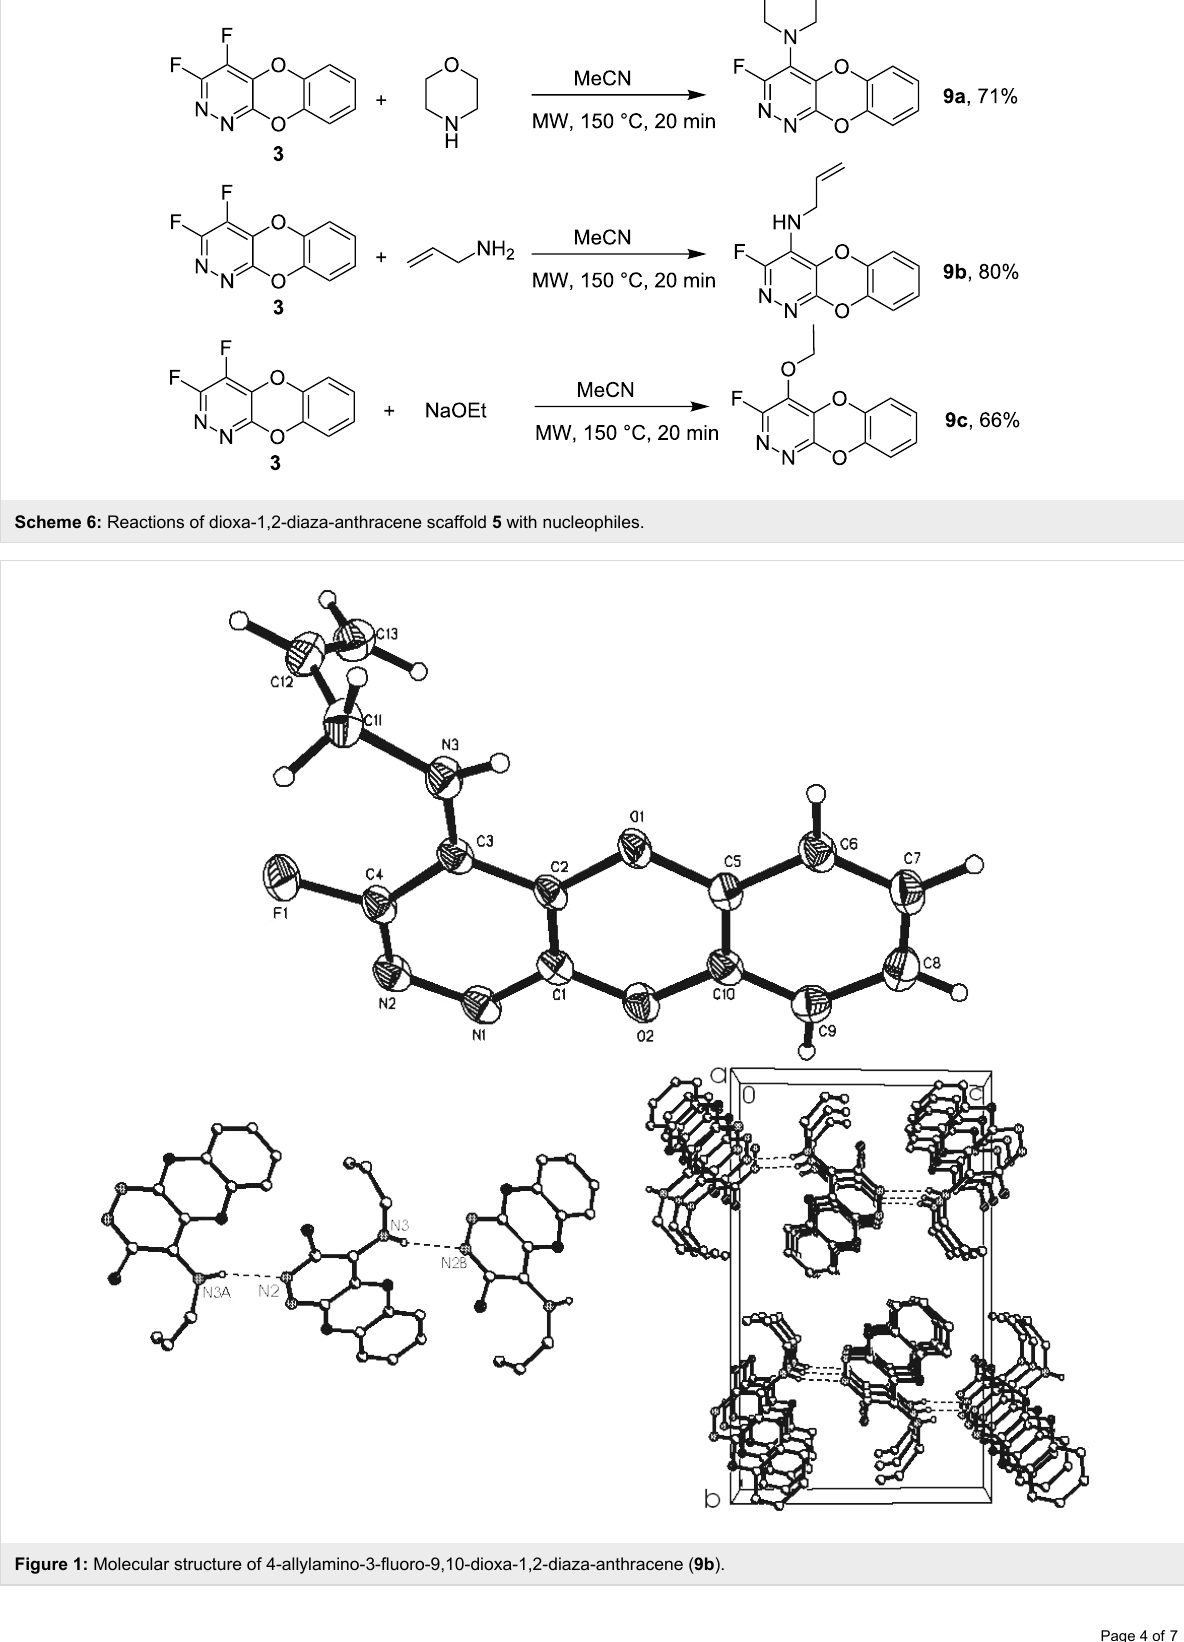
Figure 1: Molecular structure of 4-allylamino-3-fluoro-9,10-dioxa-1,2-diaza-anthracene ( 9b